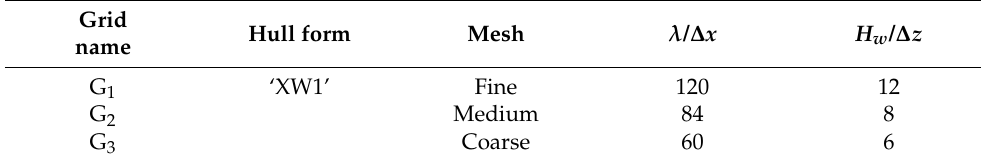
Table 6. Grids used for convergence tests for XW1 model.